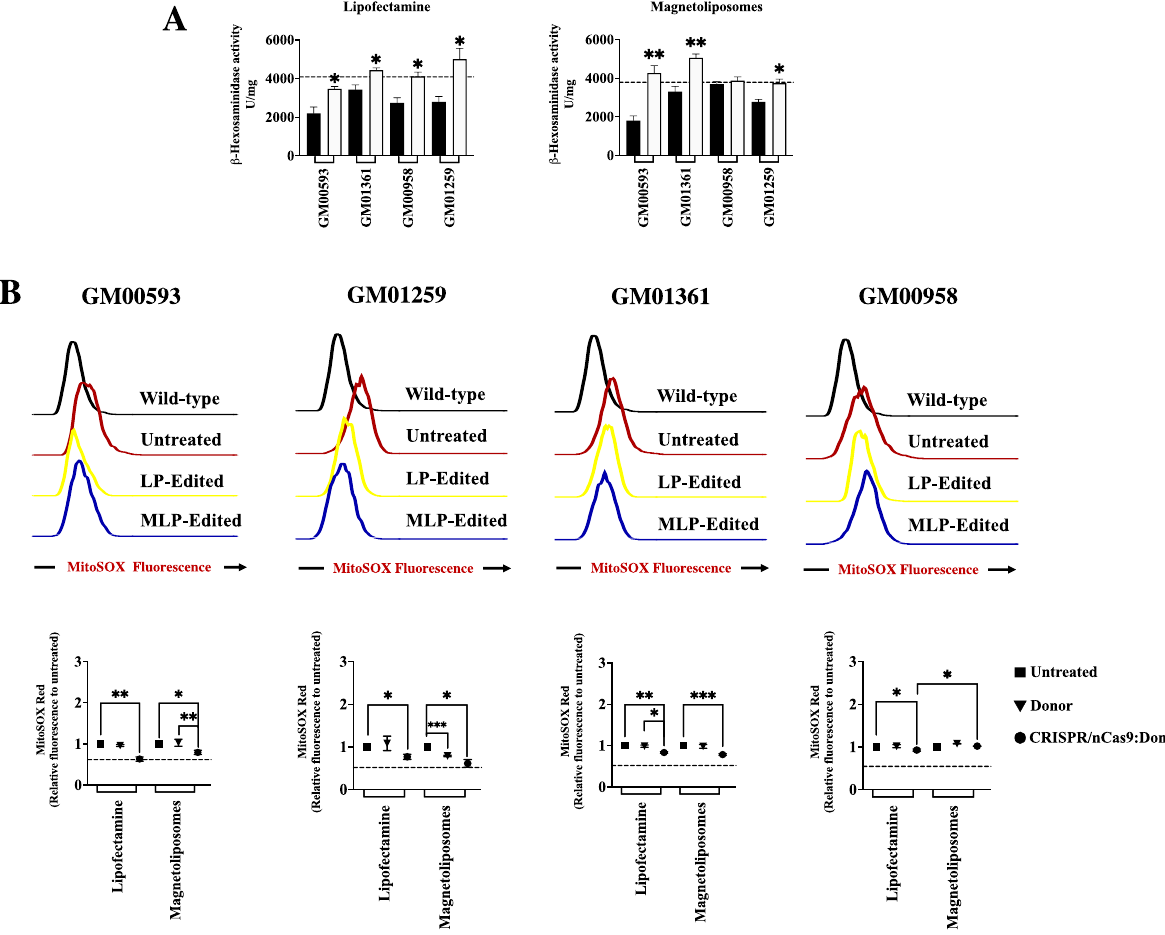
Figure 5. Restoration of lysosome flux and mtROS. ( A ) Recovery of total β-hexosaminidase enzyme activity for LP (Left) and MLPs (Right) treated cells (n = 4). The horizontal dotted line represents the normal enzyme values on the wild-type fibroblasts. ( B ) The upper panel shows the representative histogram of relative MitoSOX red MFI for CRISPR/nCas9:Donor AAVS1 treatment. The bottom panel is the mean for each MPS IVA fibroblast obtained from experiments like the upper one (n = 4). GM00958 fibroblasts were responsive when LP was used for the CRISPR/nCas9 system delivery. Fibroblasts were transfected either with the Donor AAVS1:GALNS plasmid (Donor) or the CRISPR/nCas9-Donor AAVS1:GALNS plasmids (CRISPR/nCas9:Donor). *p ≤ 0.05, **p ≤ 0.005, ***p ≤ 0.001 . Two-tailed Student’s